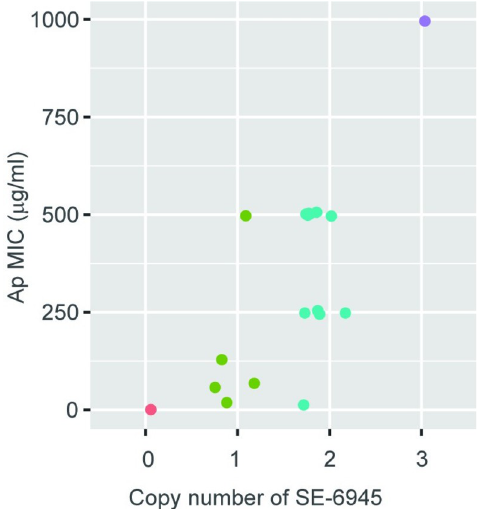
Fig 6. The copy number of SE-6945 affects the Ap resistance level. Sixteen transconjugants and a control strain (JW0452) were divided into four groups shown in distinct colors based on the SE-6945 copy number in the genome. MIC of ampicillin is shown according to copy